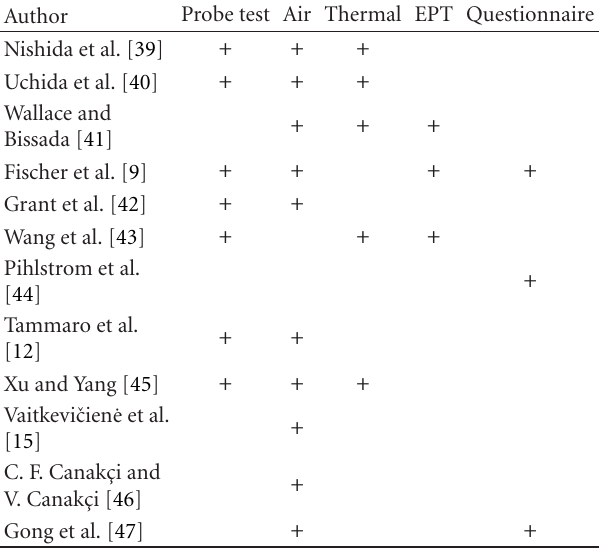
Table 4: Clinical methodology used to assess DH/RS in the included